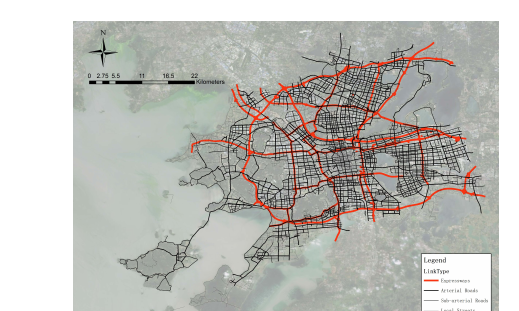
Figure 2. Ring road network of